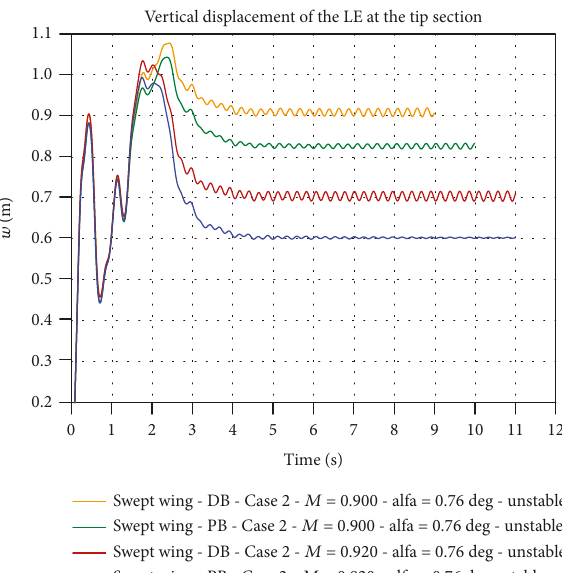
Figure 36: FSI DB and PB — displacement histories at the LE of the swept-wing tip (Case 2, α = 0 76 °